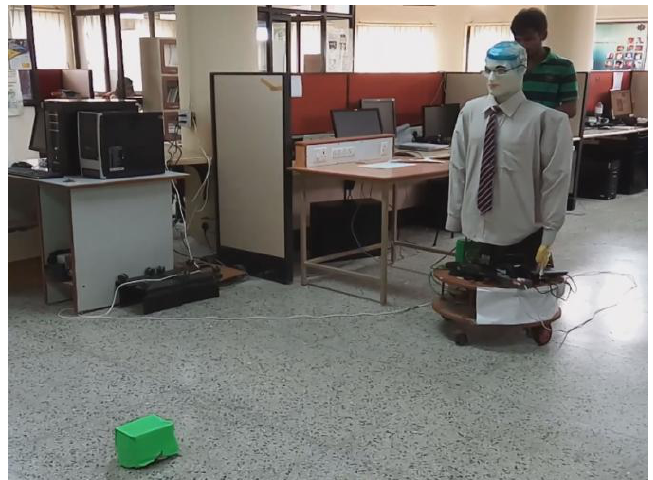
Figure 14. Results on the physical setup.